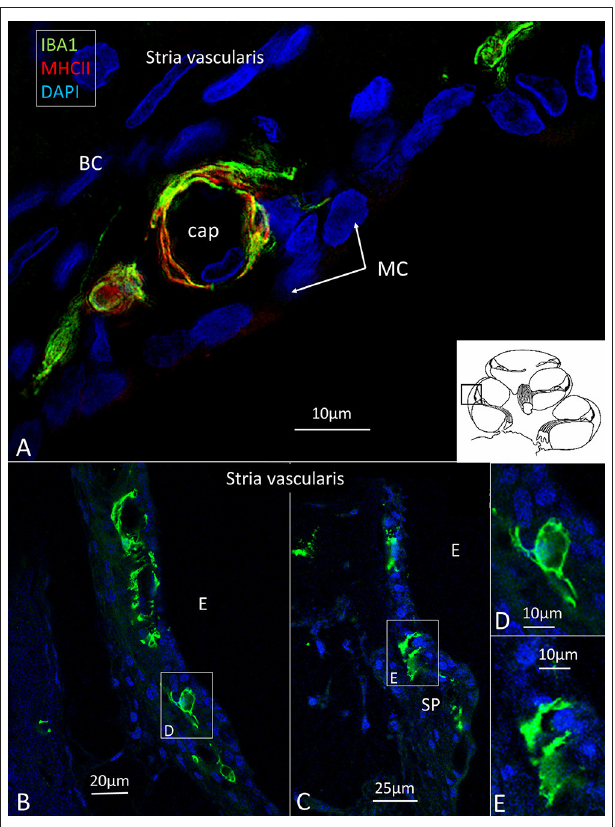
FIGURE 2 | (A) IBA1 cells located in the intermediate layer of the SV surrounding blood vessels. The cells also express MHC II. BC: basal cell. MC: marginal cell. (B–D) Macrophages located in the SV and spiral prominence. (E) Some cells reach areas between epithelial cells.